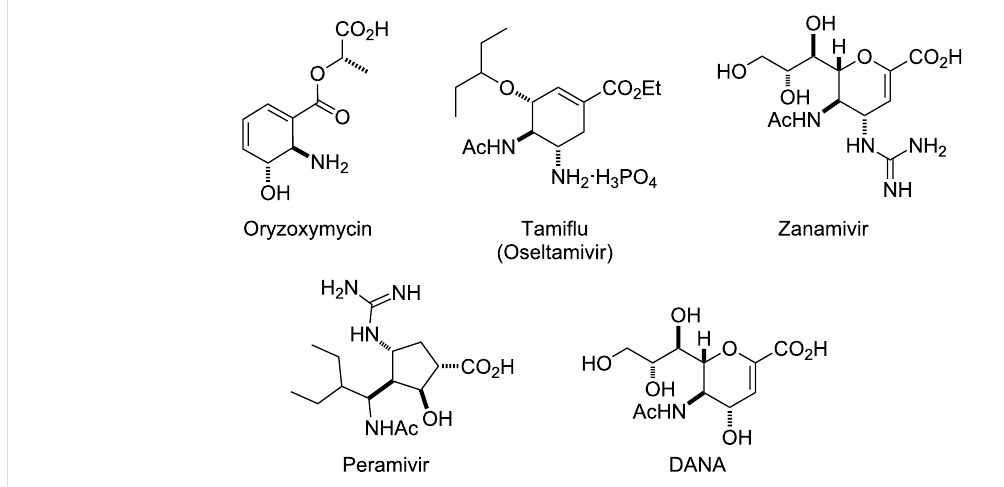
Figure 1: Structures of neuraminidase inhibitors.